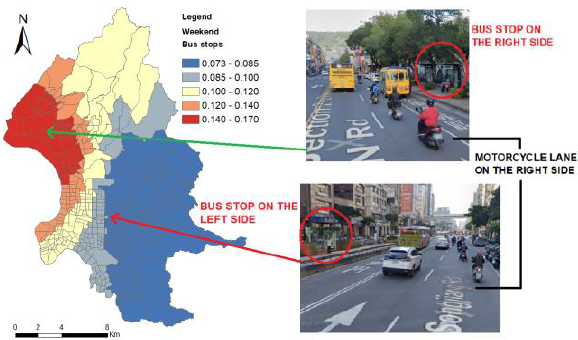
Figure 4. The spatial distribution of bus stops parameter estimation delivery motorcycle crashes on